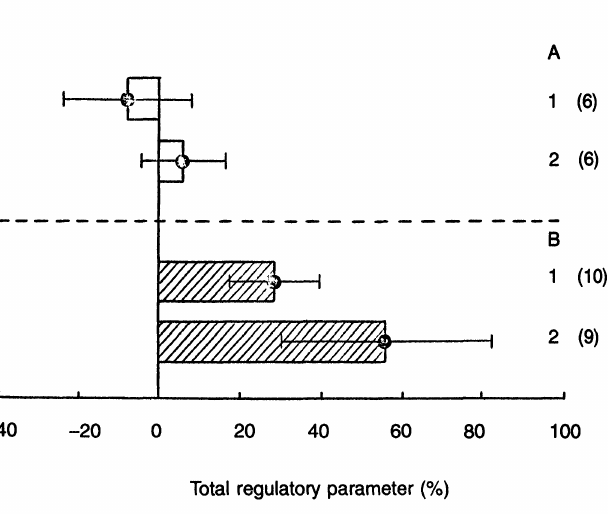
Shading: p < 0.05 2.